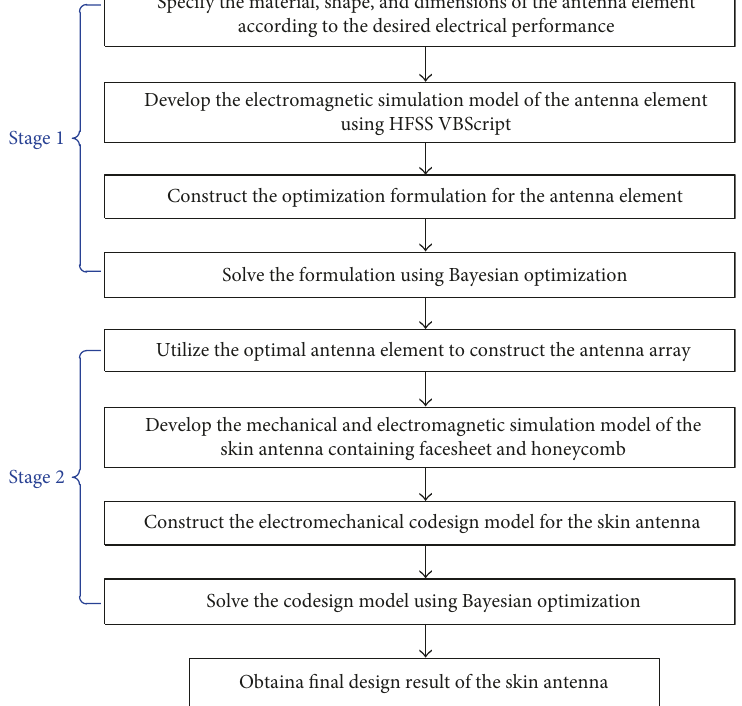
Figure 3: Flowchart of the antenna skin design.